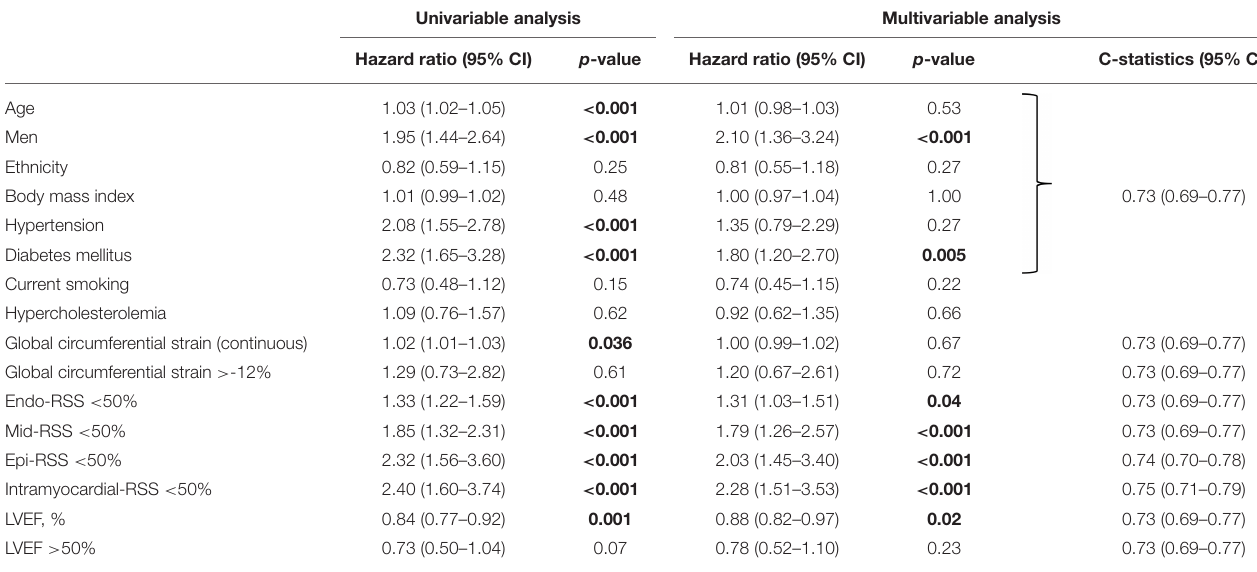
TABLE 3 | Univariable and multivariable analysis for hard CHD ( N = 1,506).